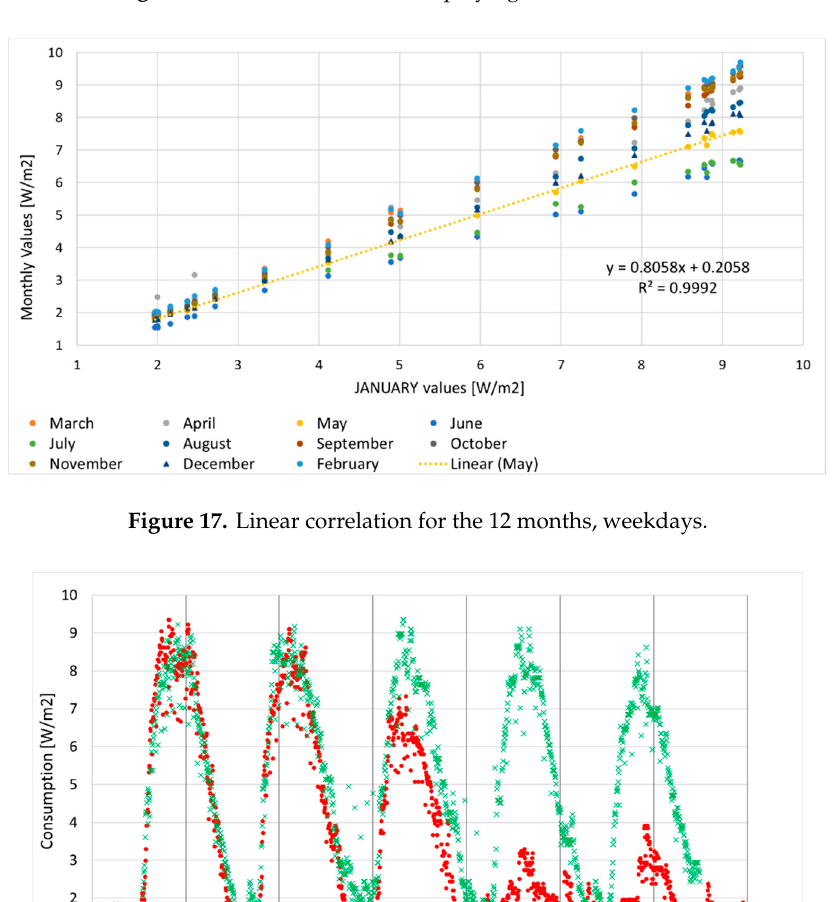
Figure 16. Correlation matrix displaying Kendall test values.